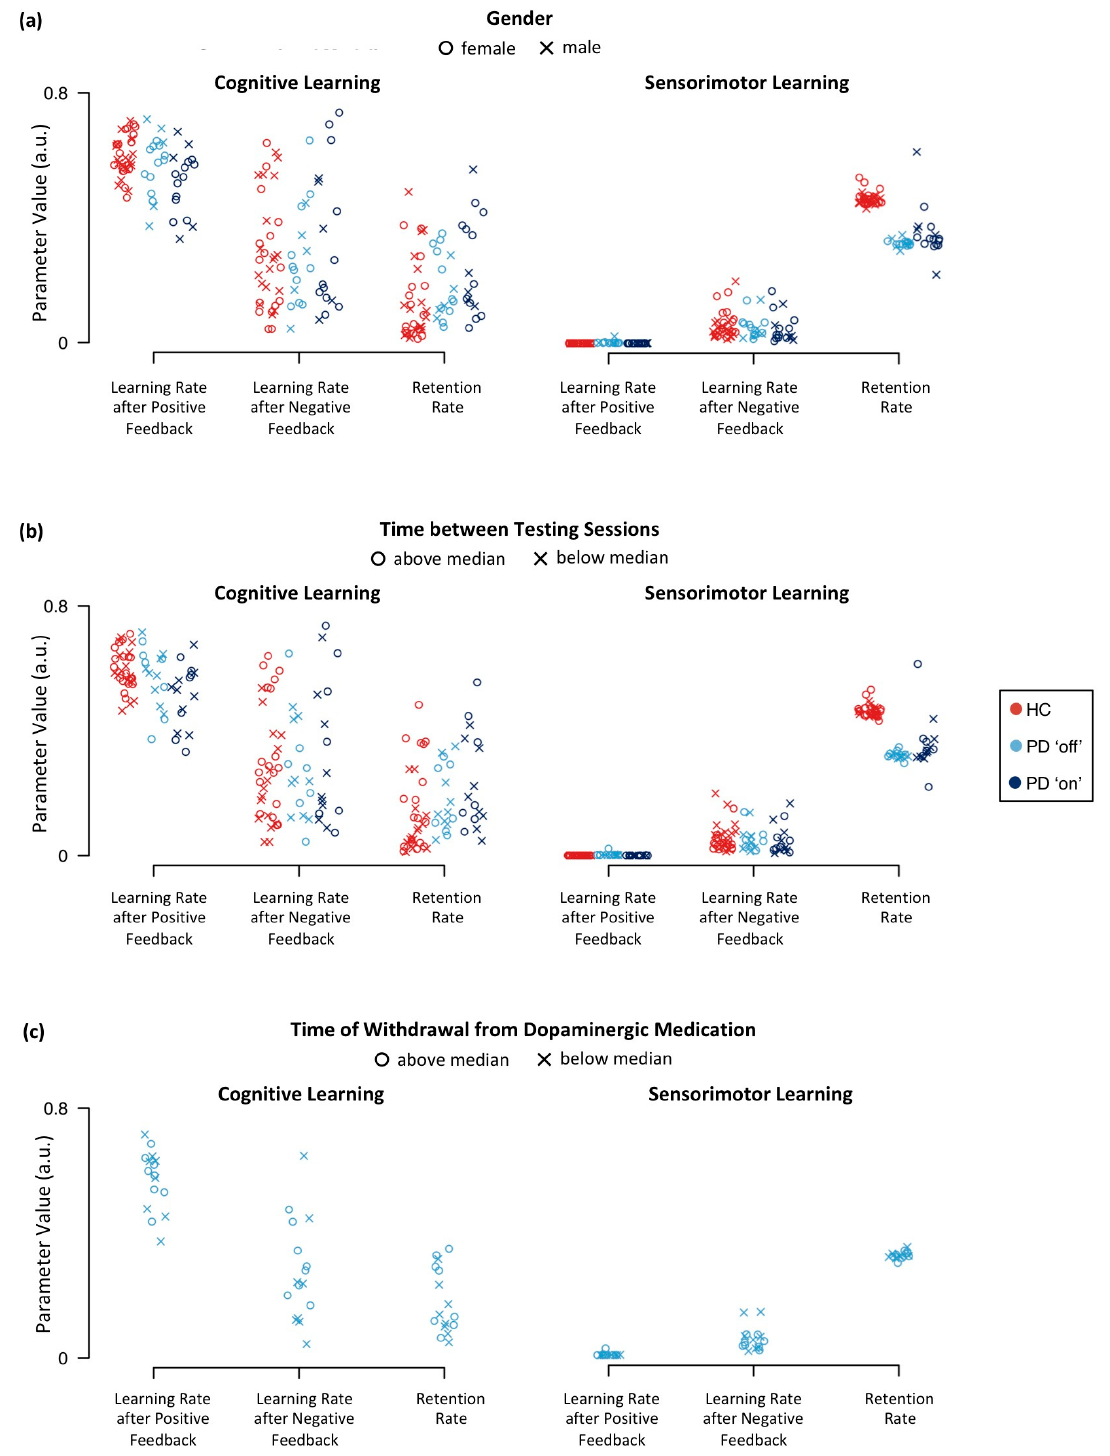
Figure A2. Medians of individual-level posterior distributions (derived by Equation (A13)) separated by ( a ) gender, ( b ) median time between testing sessions, and ( c ) median time of withdrawal from dopaminergic medication.